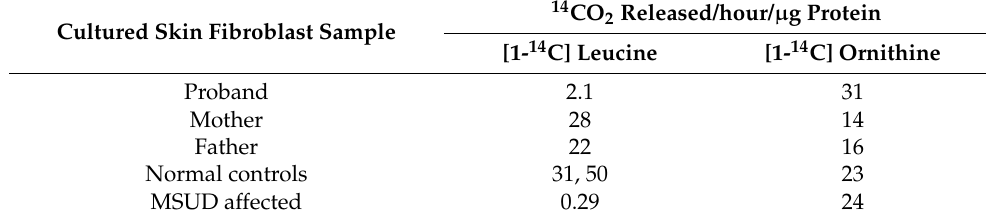
Table 1. Leucine decarboxylation study results.